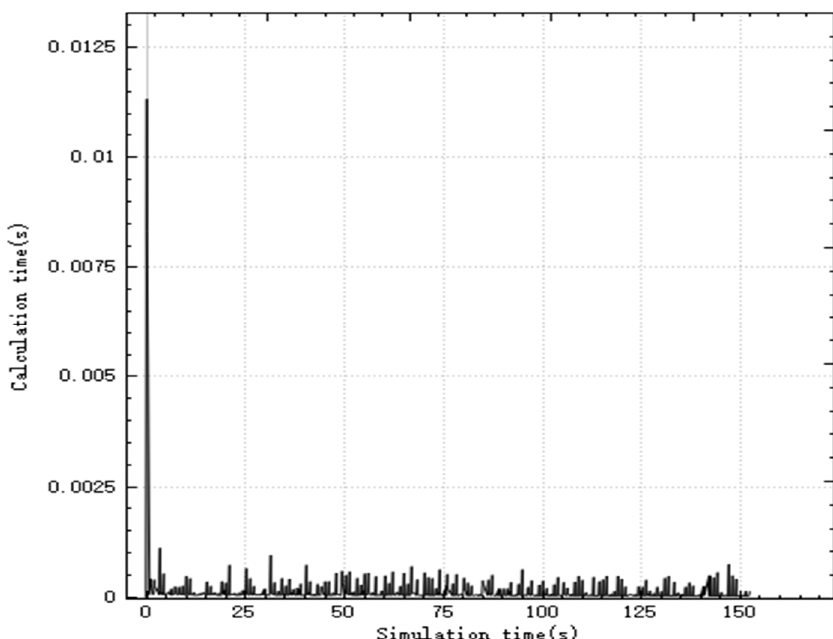
Figure 3. Calculate time-consuming curve in each step.